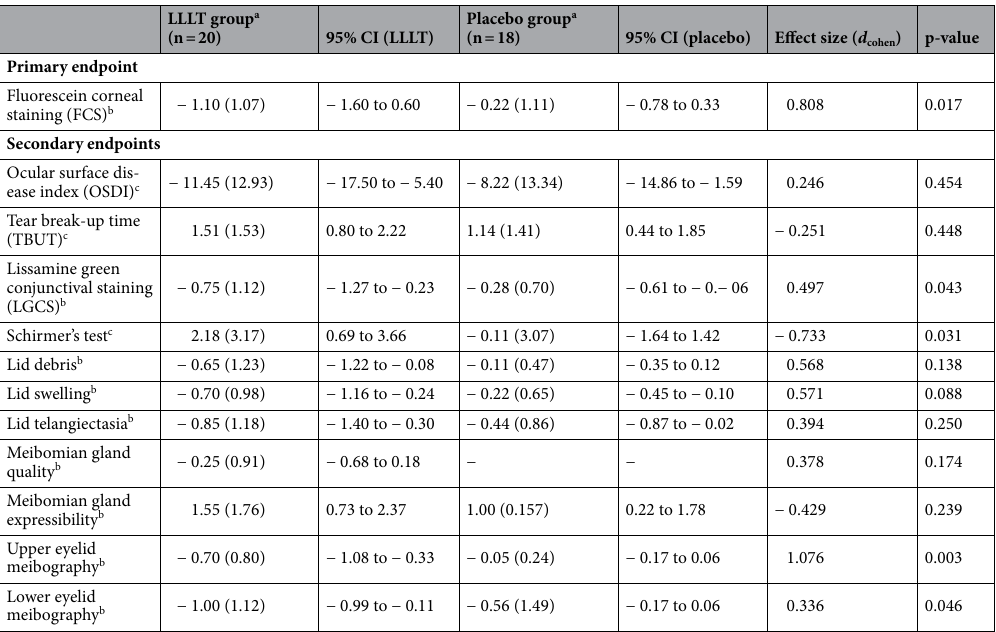
Table 5. Per-protocol analysis for the score changes of primary and secondary endpoints after LLLT interventions. a Post-Pre test scores. b Wilcoxon rank sum test results. c Independent sample